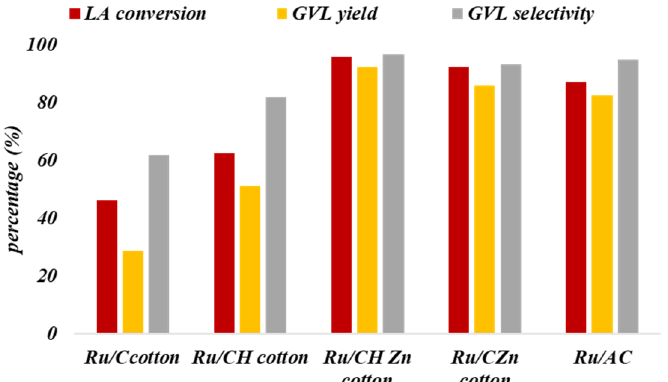
Figure 3. Support effect over Ru-supported carbonaceous materials in levulinic acid HDO reaction. Reaction conditions: 120 min, 100 ◦ C, 10 mL of H 2 O, (LA) 0.5 M, 10 mg of catalyst, 10 bars P H2